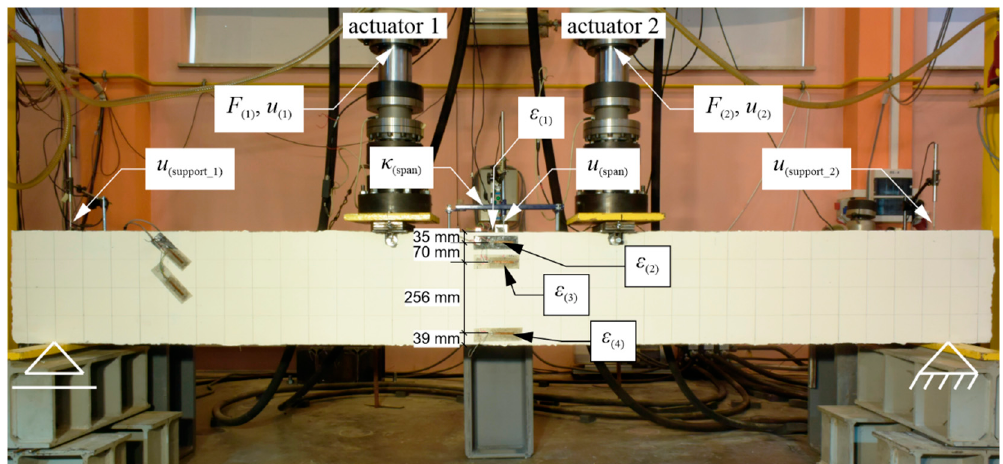
Figure 10. View of beam #1 on the test stand showing the places where the measurements were made (description of the symbols in the text).